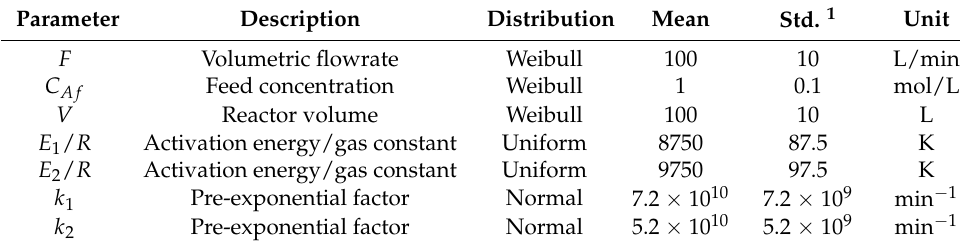
Table 8. Description of model parameters in Example 3